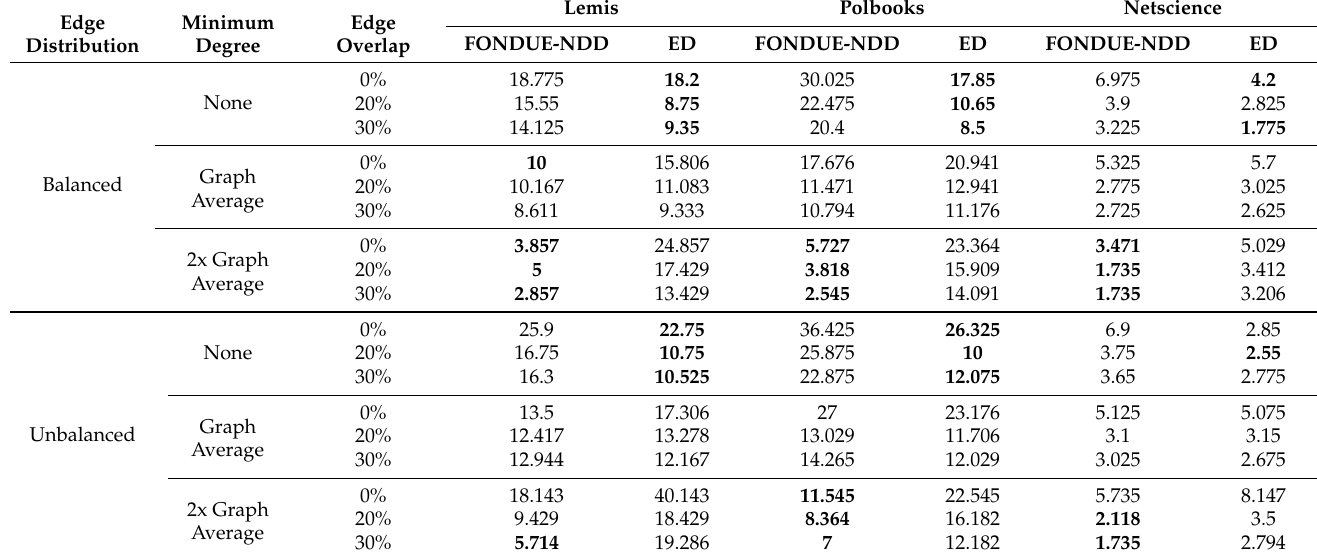
Table 8. Results of the controlled experiments for each dataset. The average ranking of objective cost function over 100 different trials. The lower, the better. Bold numbers indicate that the difference in averages are significant ( p < = 0.05 ) . Edge Minimum Distribution Degree